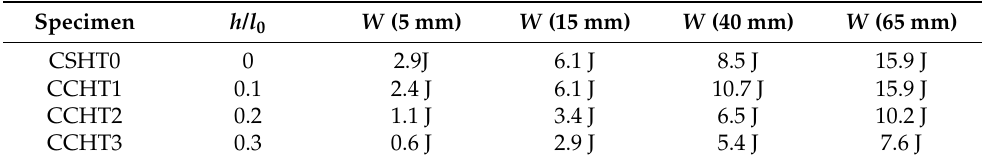
Figure 11. Comparison of deformation energy curves of the CCHT0, CCHT1, CCHT2, and CCHT3 under quasi-static loading conditions. Table 2. The energy absorbed by the specimen when the displacement is 5 mm, 15 mm, 40 mm, and 65